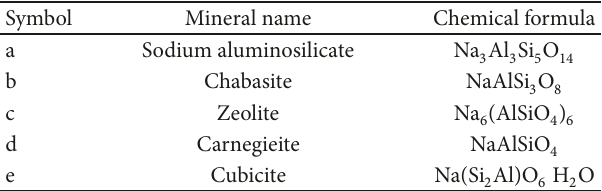
Table 5: The phase corresponding to XRD